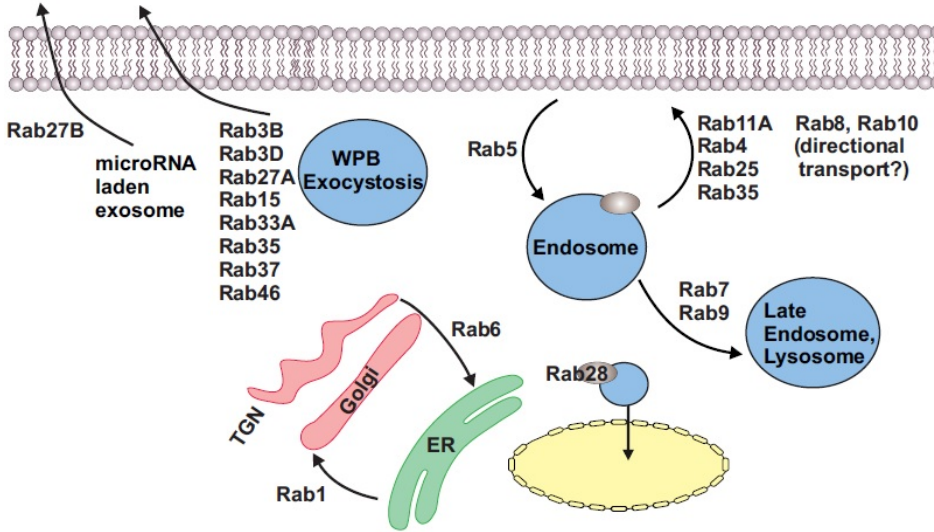
Figure 1. Rab GTPases and their known functions in endothelial and smooth muscle cells.